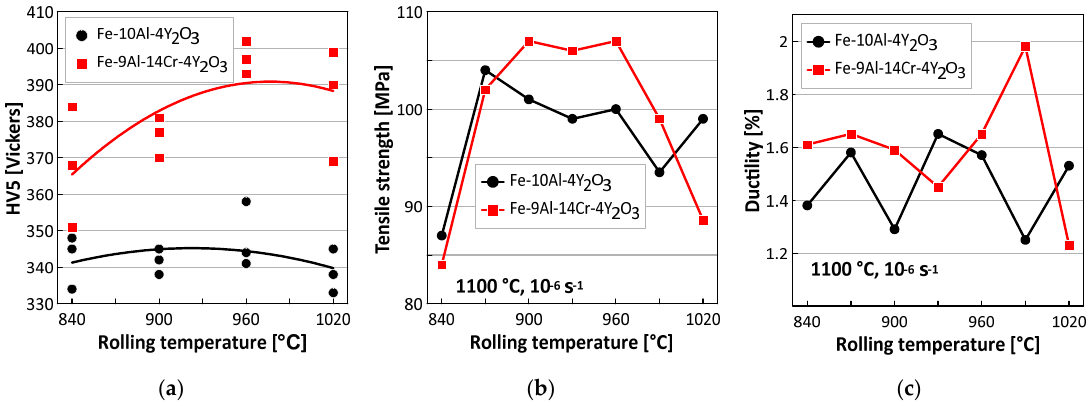
Figure 5. Summarizing results of influence of rolling temperature on ( a ) hardness measurements, and on ( b ) strength and ( c ) ductility determined by tensile testing at strain rate and temperature 1100 °C.